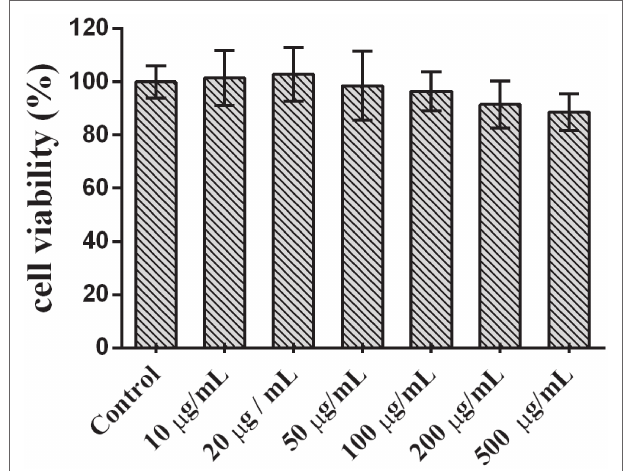
FIGURE 7 | Lycium barbarum polysaccharide cytotoxicity in Caco2 cells.